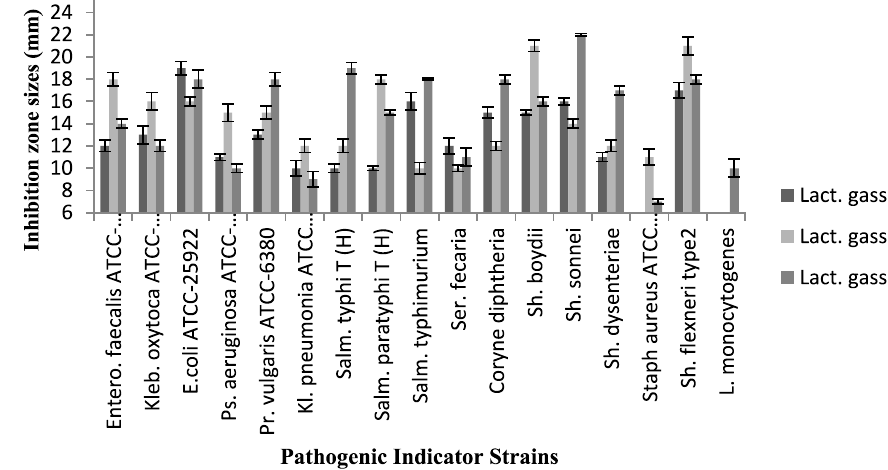
Fig. 1. Antimicrobial activity of Lact. gasseri strains against toxic food-borne and enteric pathogens The antimicrobial activities of Lact. gasseri strains against seventeen enteric pathogens were evaluated and presented by measuring the diameters of growth inhibition zones around the well as mean ± SD from three